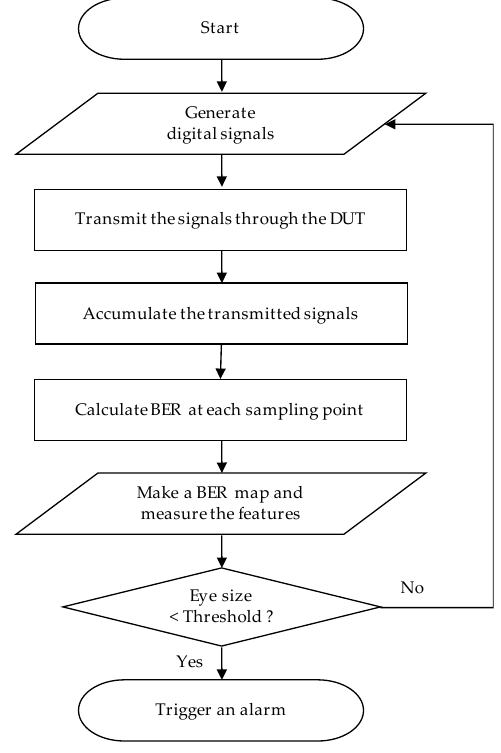
Figure 7. On-chip health sensing flowchart using BER.